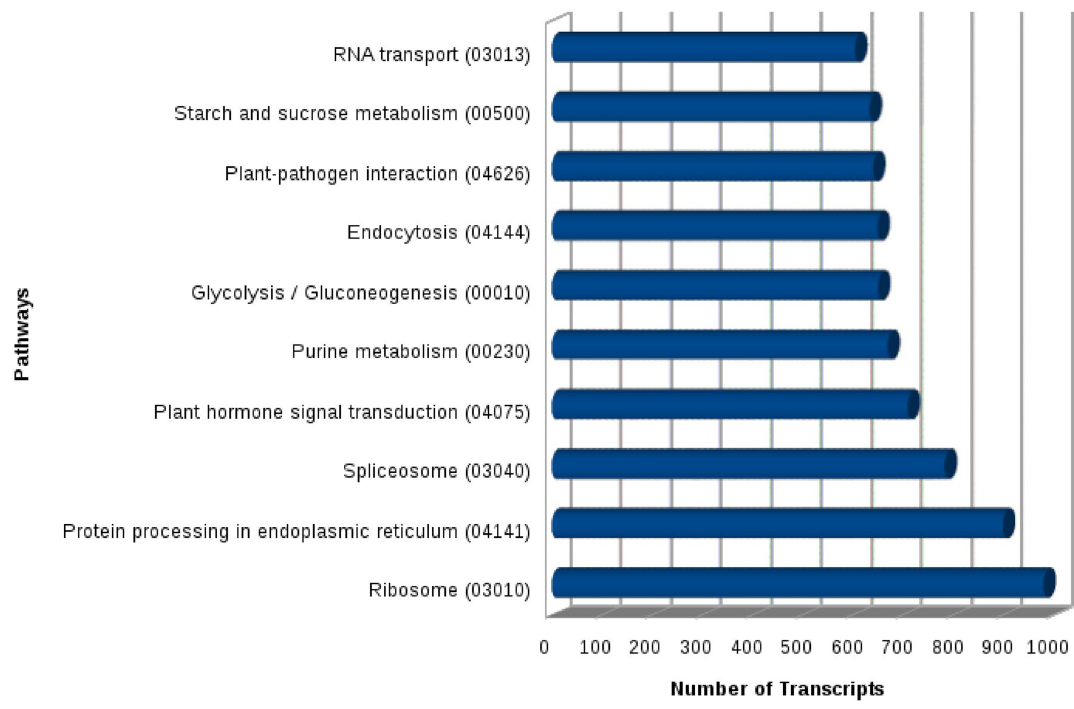
Figure 5. Top 10 most highly represented pathways in Urochondra